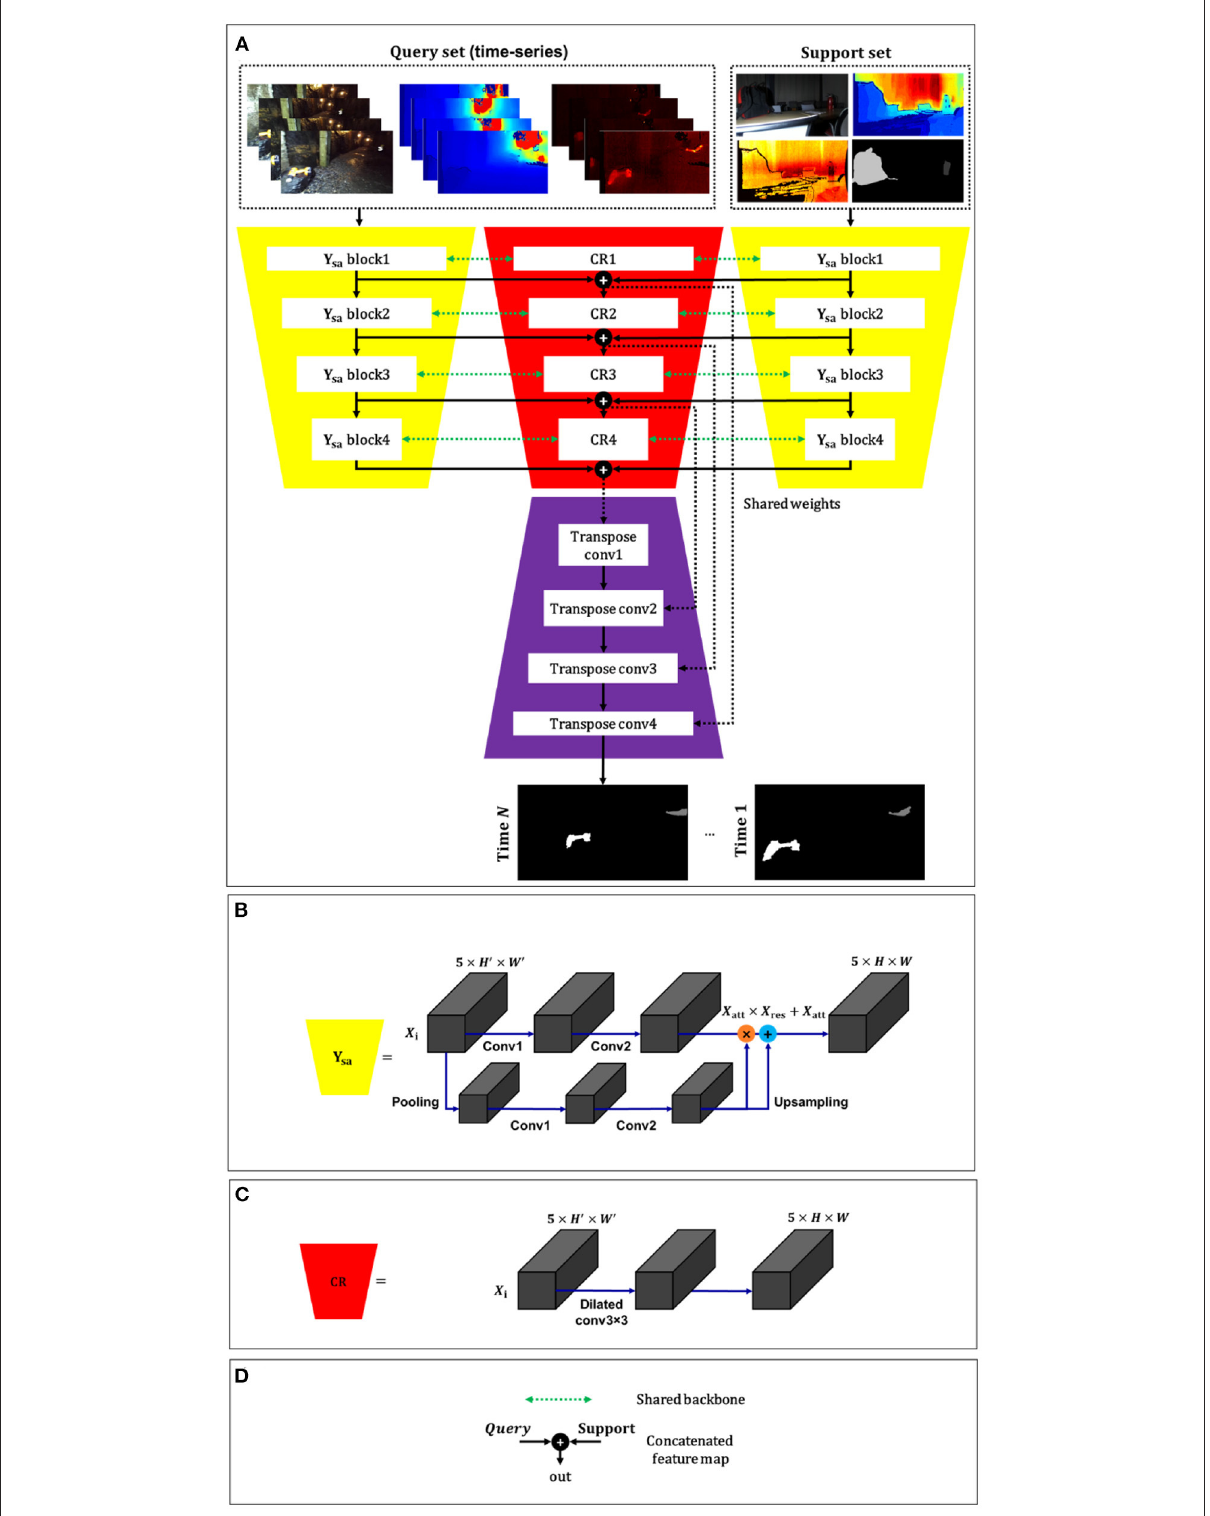
FIGURE1 Overview of our method for multimodal few-shot learning. (A) Proposed architecture for feature extraction and real-time multiple target segmentation, (B) proposed squeeze-and-attention mechanism, (C) proposed class registration (CR) network, and (D)